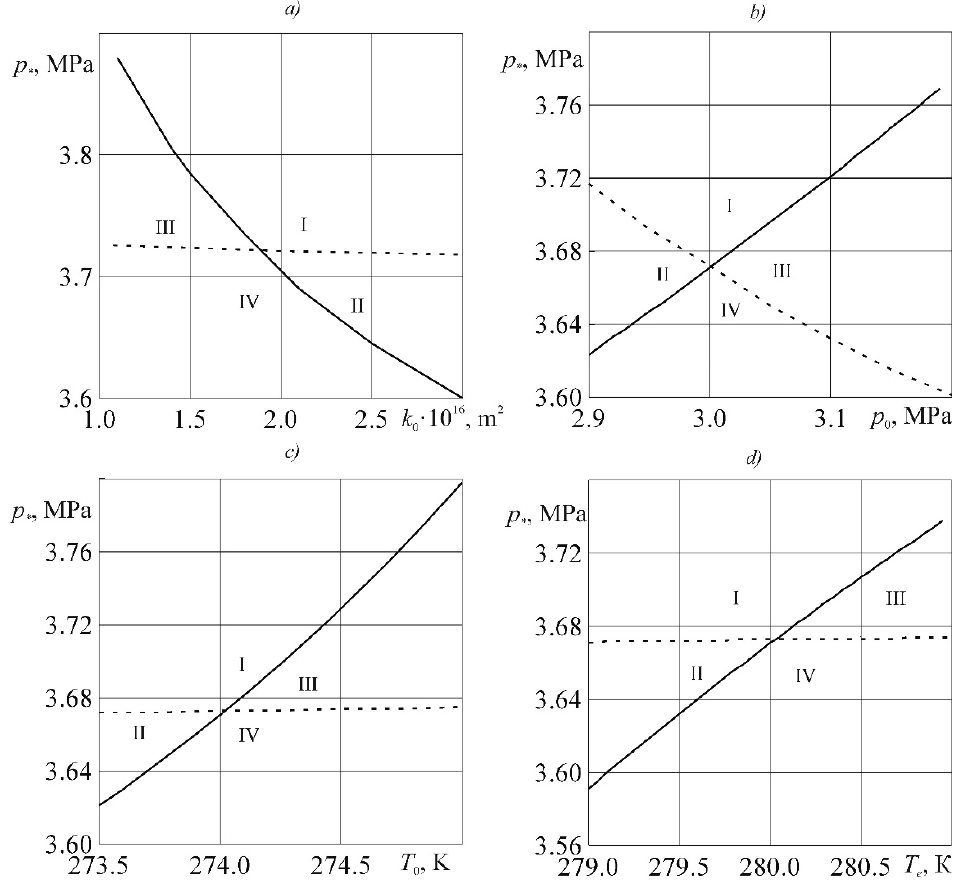
Figure 7. Dependences of the values p * on the porous medium permeability k 0 ( a ), on the pressure value at the right reservoir boundary p 0 ( b ), on the initial reservoir temperature T 0 ( c ) and on the injection temperature T e ( d ).